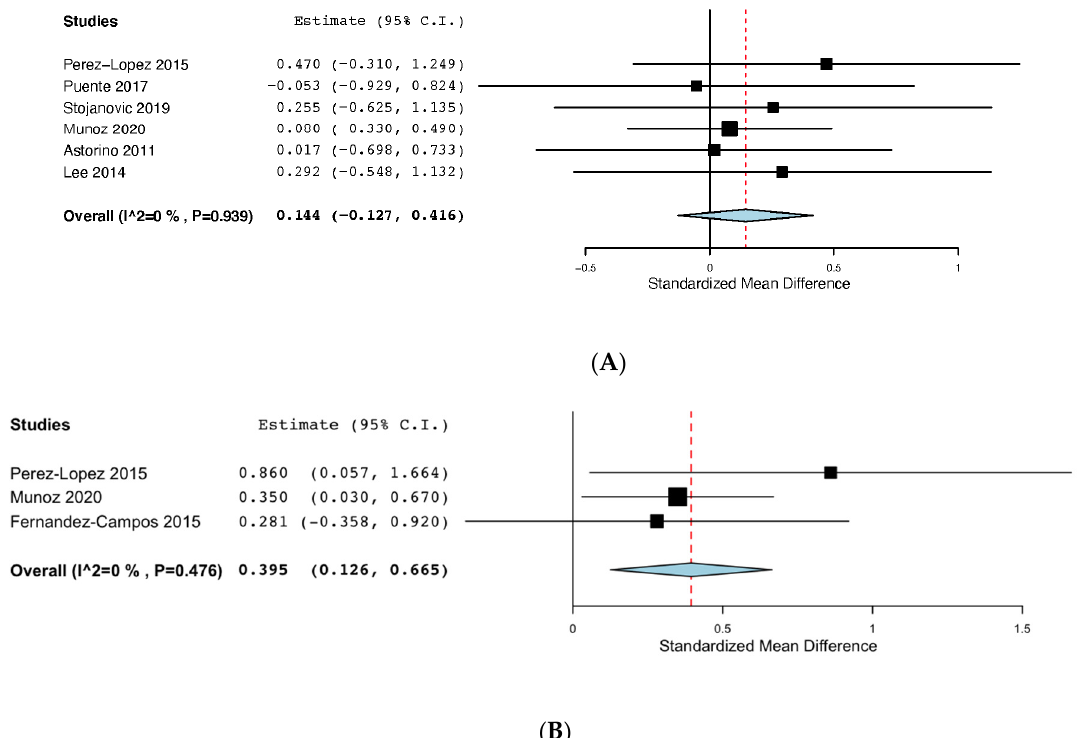
Figure 3. ( A ): Effects of caffeine on agility. ( B ): Effects of caffeine on handgrip strength.